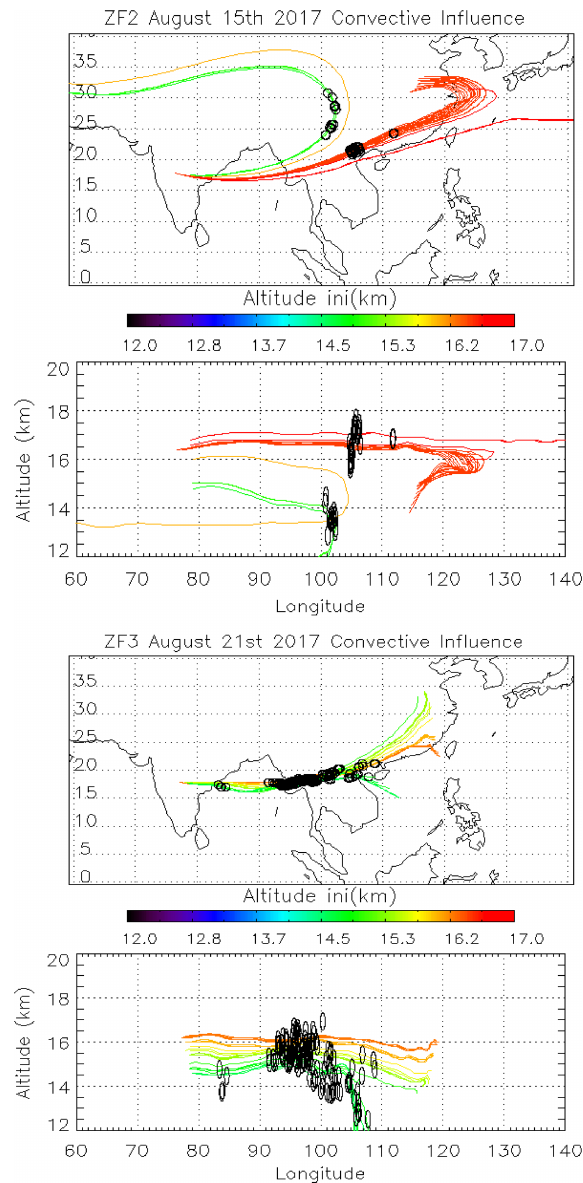
Figure 5. Back trajectories initialized from ZF2 (15/08) and ZF3 (21/08) measurements between 150 and 70hPa. Black dots along the trajectories are the position of convective systems intersecting air masses sampled during the balloon